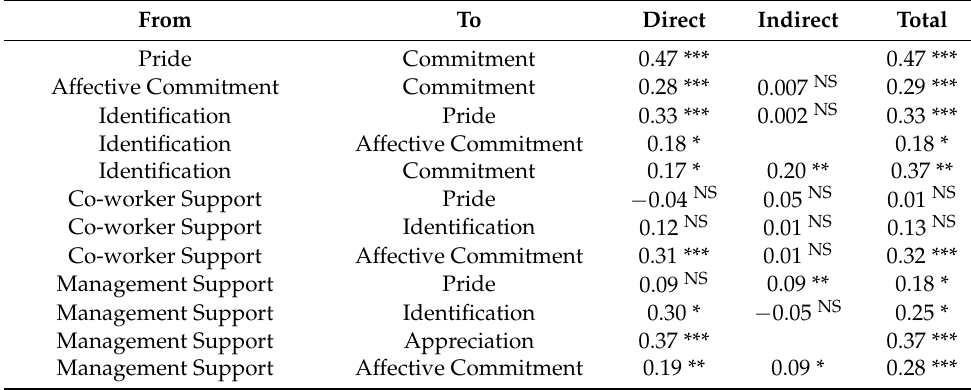
Figure 1. Partial least squares (PLS) model. All the significant relationships (*** significant at 0.01, ** significant at 0.05, * significant at 0.1) are described in Figure 1, where the weights of the arrows correspond to the magnitude of the effect (weak, medium or large). The R 2 of the different concepts correspond to the amount of variance that was explained by the related concepts in the model. The PLS path modeling achieved not only a significant goodness of fit but also a model that explains most of pride’s variance (R 2 = 0.80). Table 2. Direct and indirect effects.